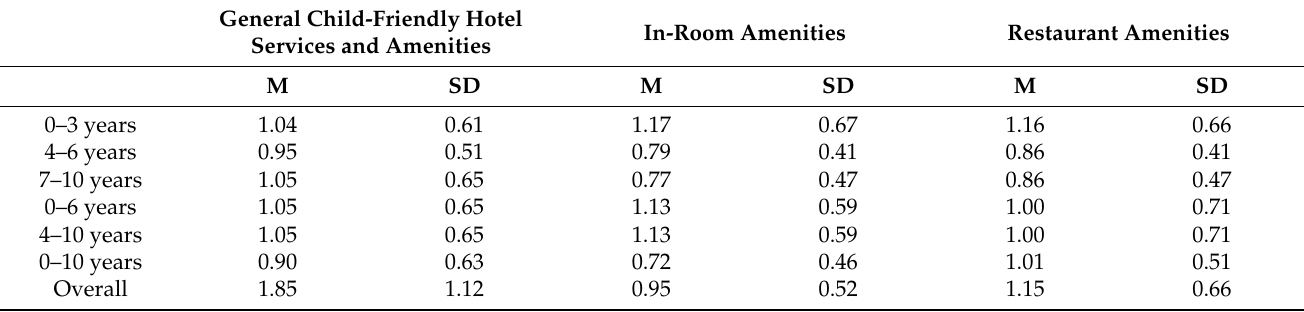
Table 3. Ranking of hotel amenities based on parents’ surveys compared to hotel